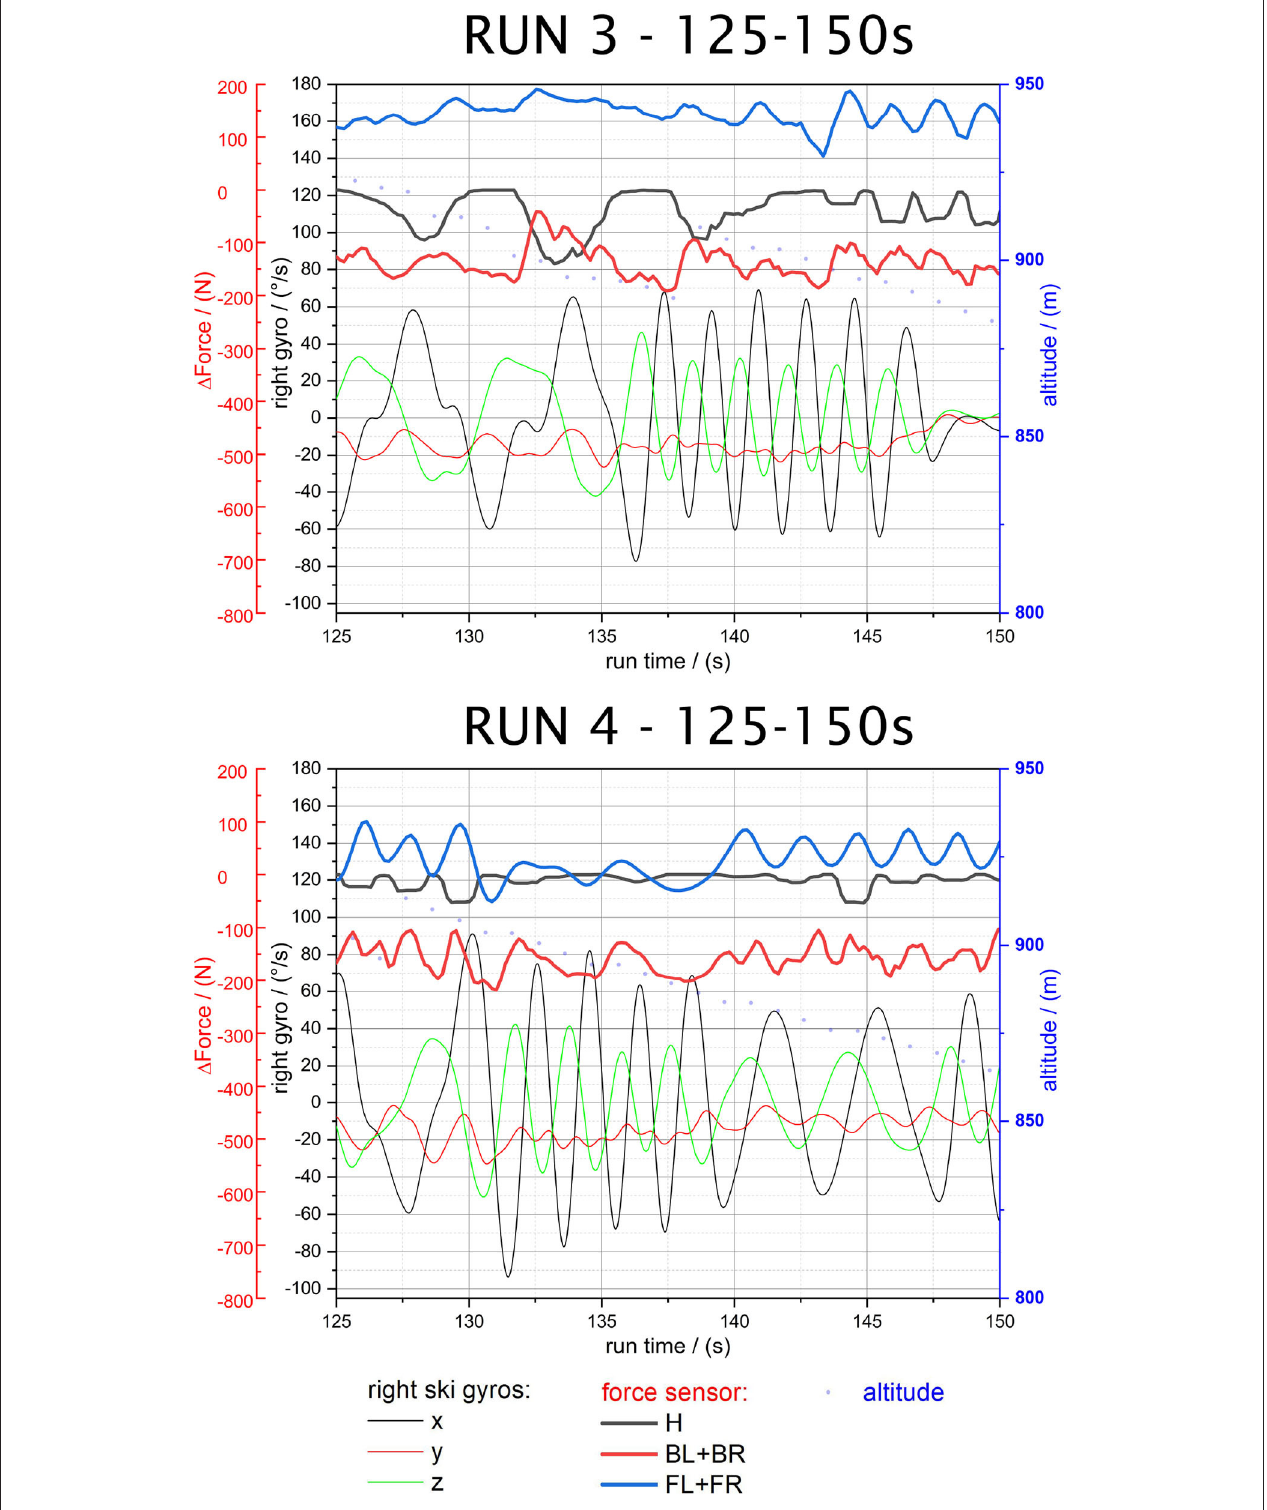
FIGURE 7 | Run 3—125–150 s and Run 4—125–150